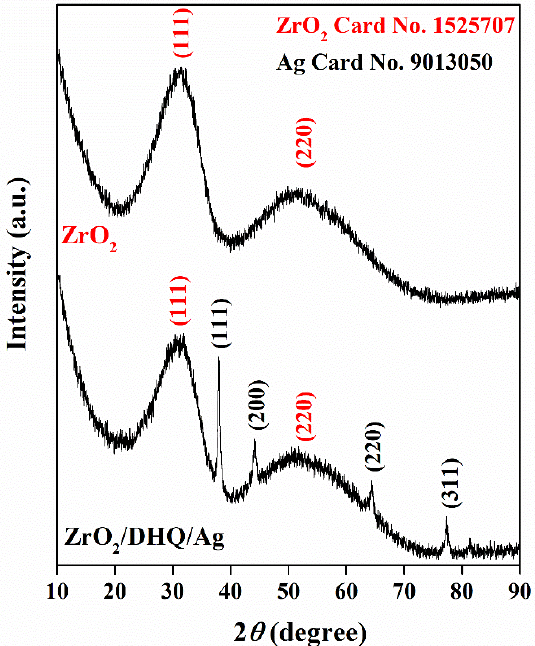
Figure 1. The XRD patterns of unmodified ZrO 2 powder and ZrO 2 /DHQ/Ag nanocomposite. TEM analysis of the unmodified ZrO 2 nanopowder (Figure 2a) revealed